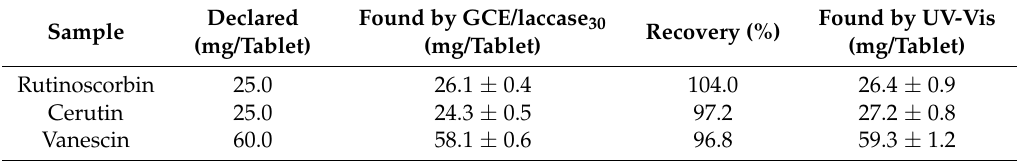
Table 1. Results of the determination of Rutin (n = 3) in pharmaceutical